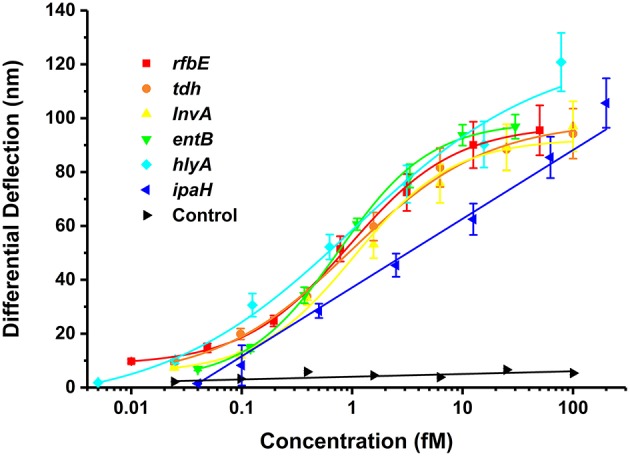
Relationship between differential deflection (nm) and the concentration (fM) of the specific genes of foodborne bacteria at series of gradient concentrations (n = 3).